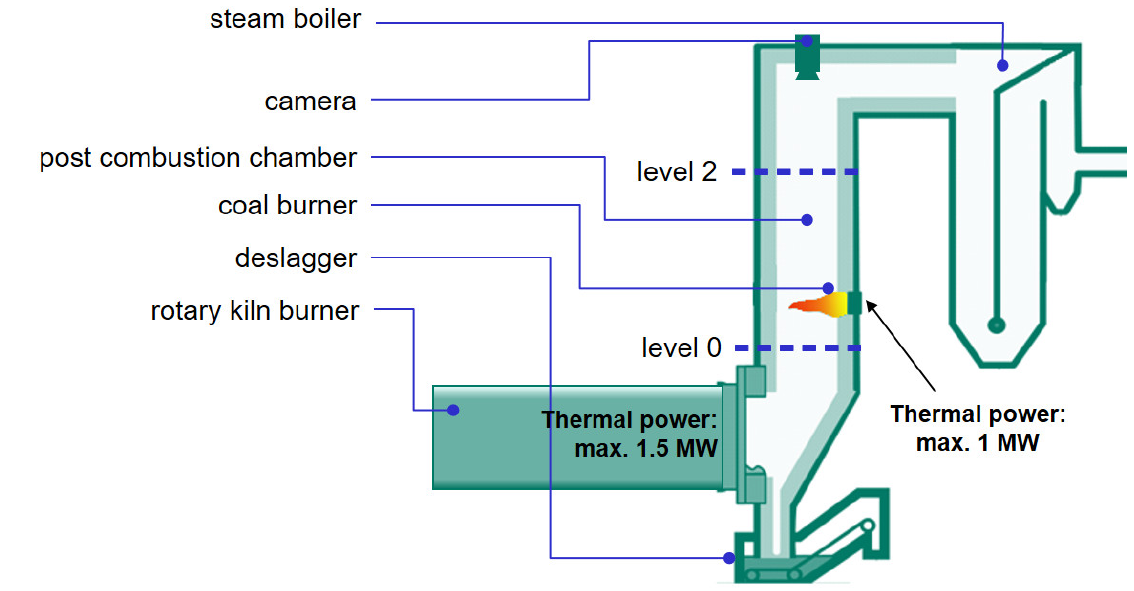
Figure 4. Pilot-scale combustion plant BRENDA.